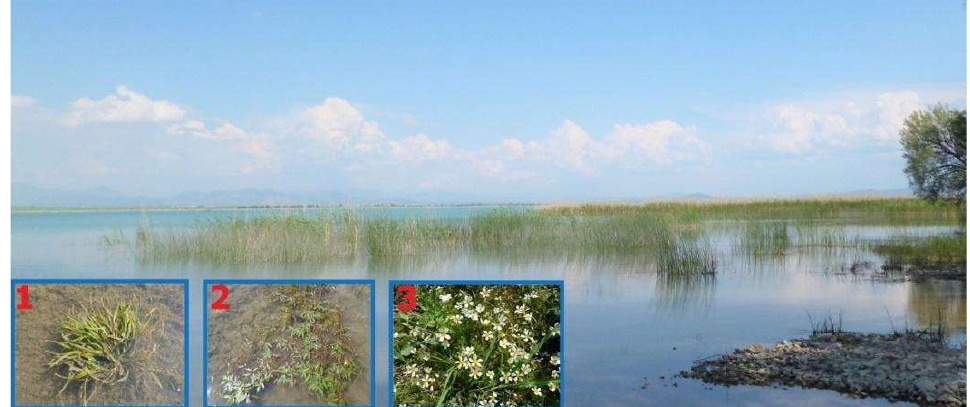
Figure 8. Beyşehir Lake shore with phragmites, and macrophytes (1: Potamogeton natans , 2: Sagittaria subulata , 3: Ranunculus aquatilis ); photographed by Ahmet Altındağ on May 2014; produced by Burçin Aşkım Gümüş on April 2022.